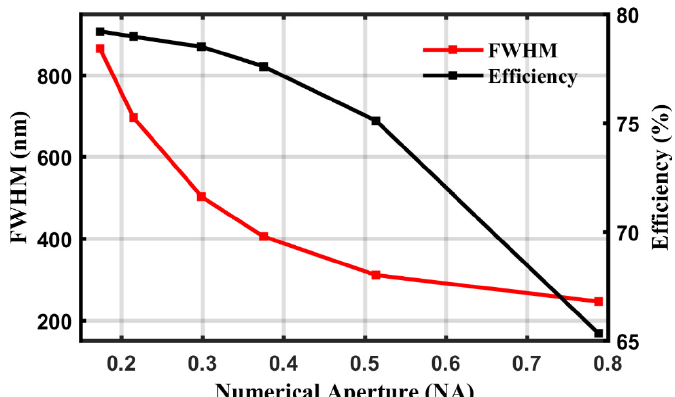
Figure 5. The FWHM of horizontal cuts of vortex rings and focusing efficiencies versus NA of the FOV generators under an RCP wave incidence of 355 nm. The radius of the metasurface is kept at 6 μm and the topological charge l of the OV is kept at 1.